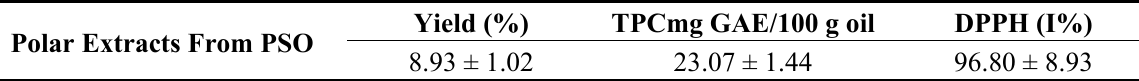
Table 1. Yield, total polyphenol content (TPC) and in vitro anti-oxidant properties of the hydrophilic fraction of PSO. TPC is expressed as mg gallic acid equivalent/100g oil; antioxidant activity is expressed as percentage of inhibition (% I) of DPPH. Results are the mean value ± standard deviation. Polar Extracts From PSO